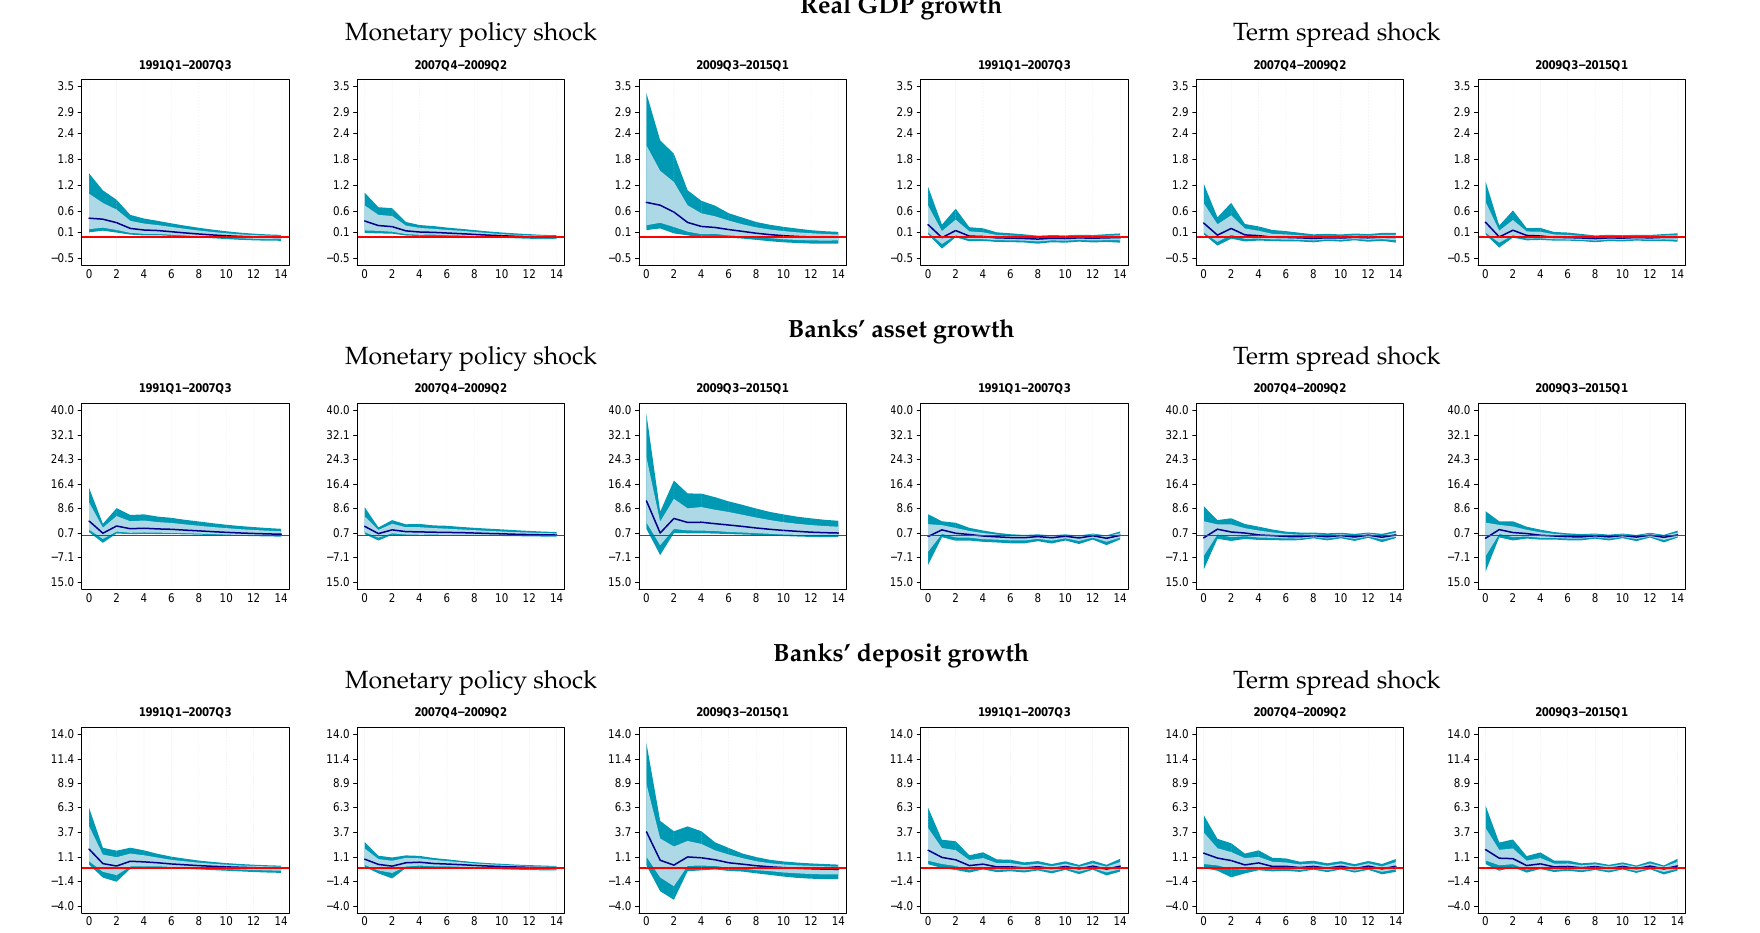
100 bp) and 100 bp) and shock to the term − −